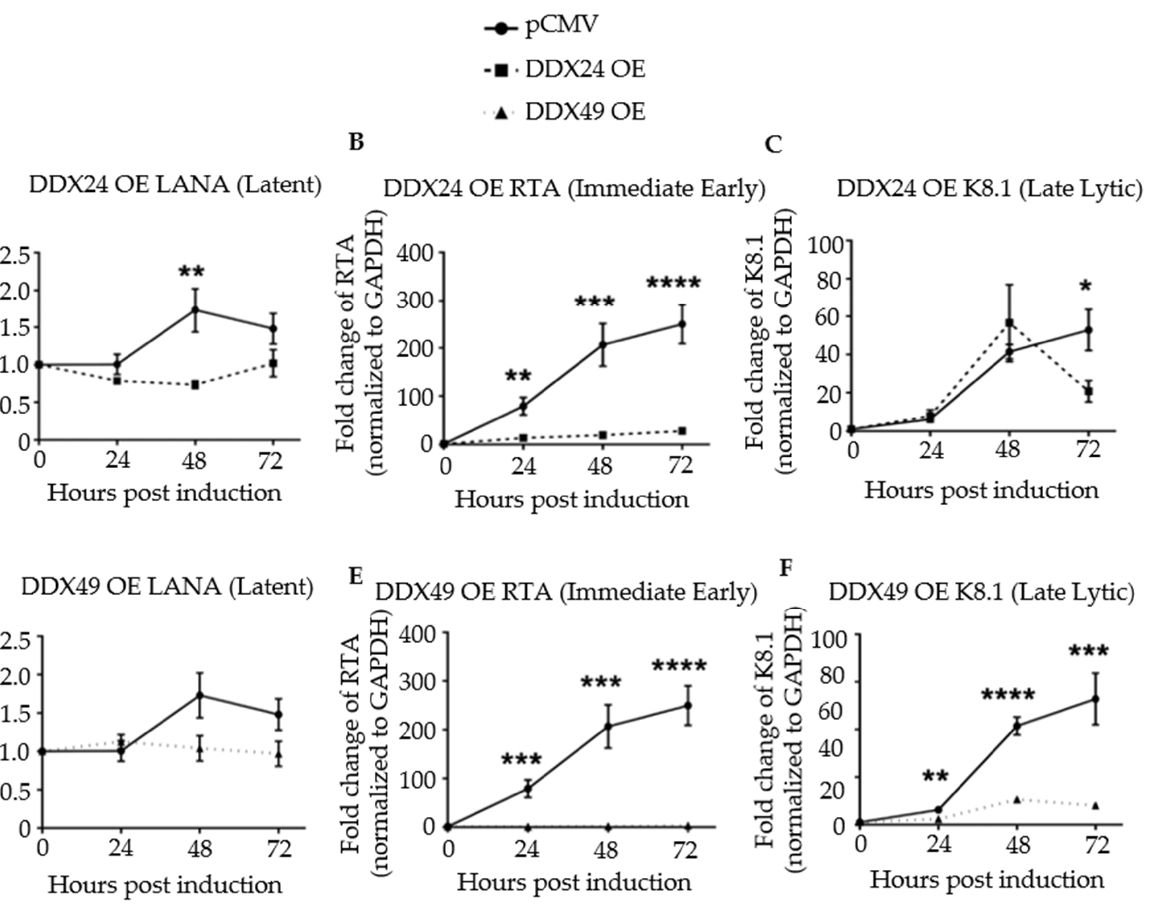
Figure 3. Expression of latent, immediate early, and late lytic genes in induced BCBL-1 cells over- expressing DDX24-DDK or DDX49-DDK. Cells were induced with 2 mM sodium butyrate and the levels of LANA, RTA and K8.1 transcripts determined by RT-qPCR at 24-, 48- and 72 h post-induction. ( A ) LANA transcript levels in BCBL-1 cells over-expressing (OE) DDX24-DDK or with empty pCMV vector. ( B ) RTA transcript levels in DDX24-DDK OE cells or pCMV cells. ( C ) K8.1 transcript levels in DDX24-DDK OE cells or with empty pCMV cells. ( D ) LANA transcript levels in DDX49-DDK OE cells or pCMV cells. ( E ) RTA transcript levels in DDX49-DDK OE cells or pCMV cells. ( F ) K8.1 transcript levels in DDX49-DDK OE cells or pCMV cells. Statistically significant difference was observed in mean gene expression of LANA and RTA between the empty pCMV vector and DDX24 (n = 3, LANA p = 0.02, RTA p = 0.0003, K8.1 not significant). There was a statistically significant difference in mean gene expression of Rta and K8.1 between the empty pCMV vector and DDX49 (n = 3, LANA not significant, Rta p < 0.0001, K8.1 p < 0.0001). * p < 0.1, ** p < 0.01, *** p < 0.001, **** p <